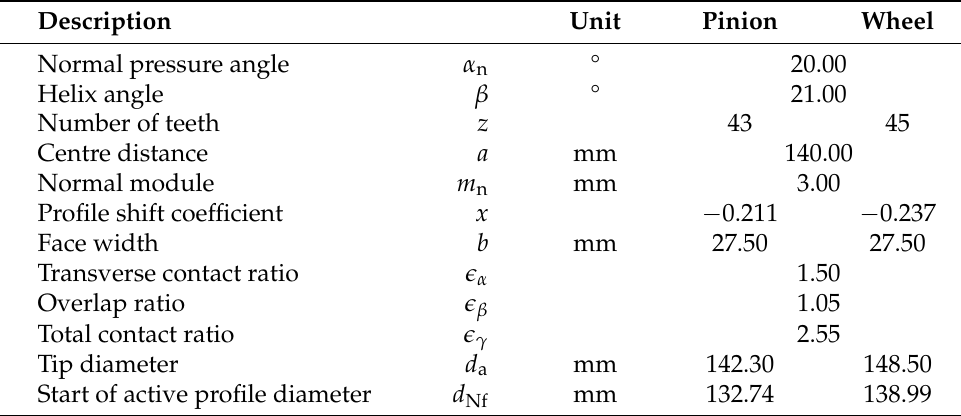
Table 1. Main parameters of the gear pair used in the experiment.